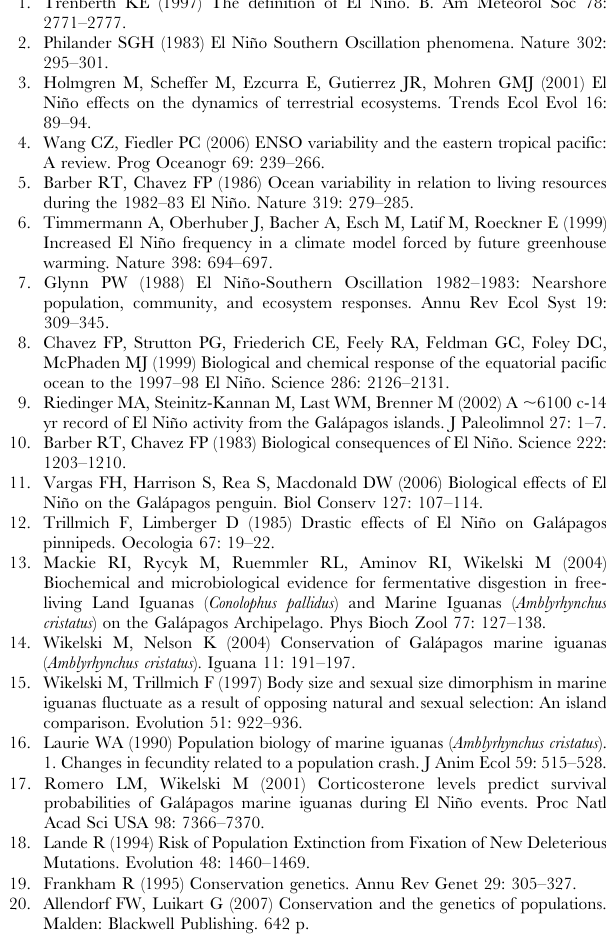
MATOR (see Methods). Point estimates for different values of Ne are shown (x-axis) with their corresponding log likelihood values (y-axis). For each island, the estimated Ne with the highest log likelihood, the calculated 95% confidence interval (CI), and the upper bound of the estimate are provided below the